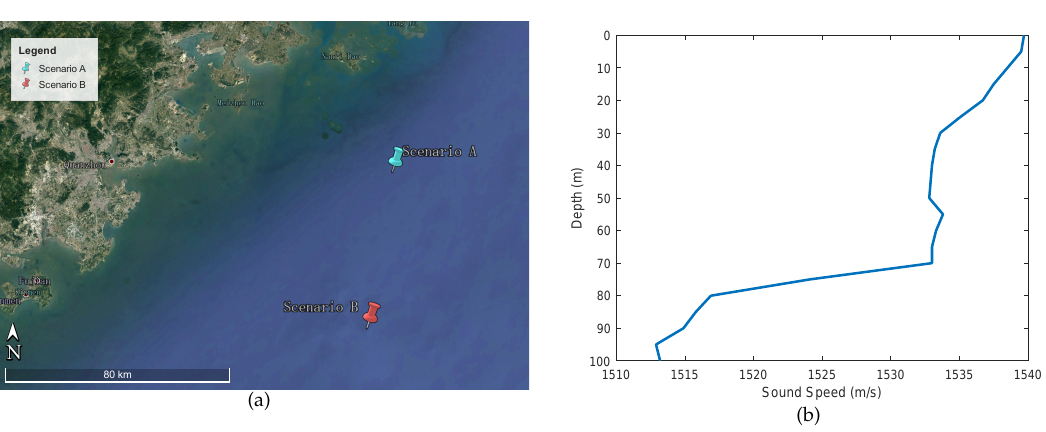
Figure 5. ( a ) Geographical location of two scenarios in simulations. ( b ) sound speed profile (SSP) curve generated from WOA2013. Table 1. Parameters of